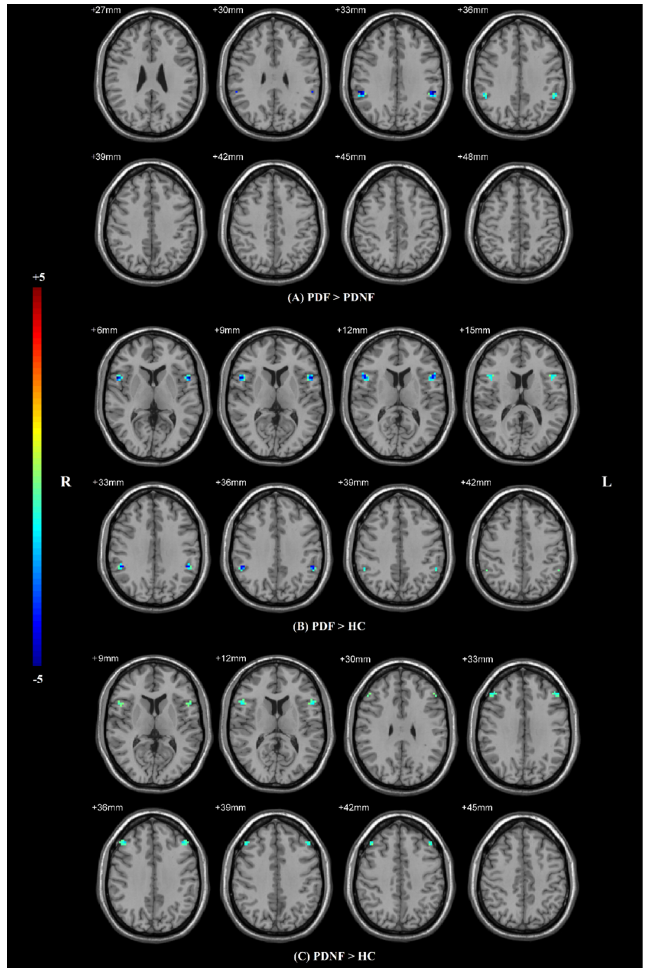
Parkinson’s disease with fatigue, PDNF: Parkinson’s disease without fatigue, MNI: Montreal Neu ‐ rological Institute, SMG: supramarginal gyri, IFG operc: opercular parts of inferior frontal gyri, MFG: middle frontal gyri.